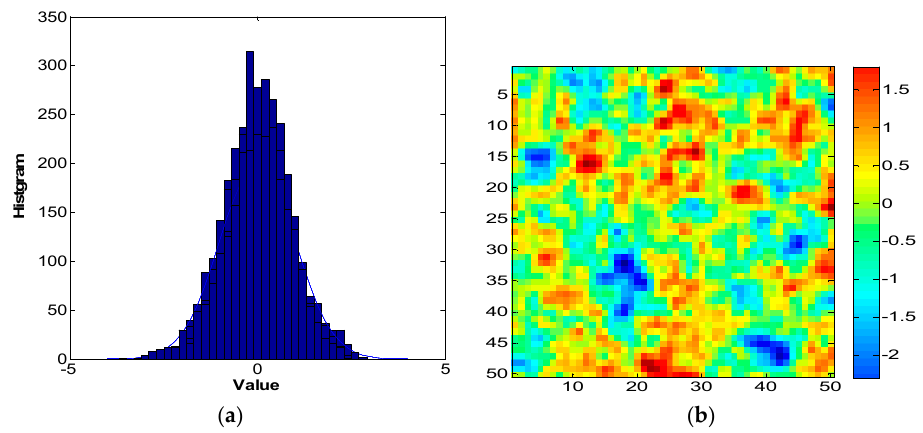
Figure 2. The random field generated by KL expansion with 1000 leading terms: ( a ) histogram of fields; ( b ) the contour of the field.